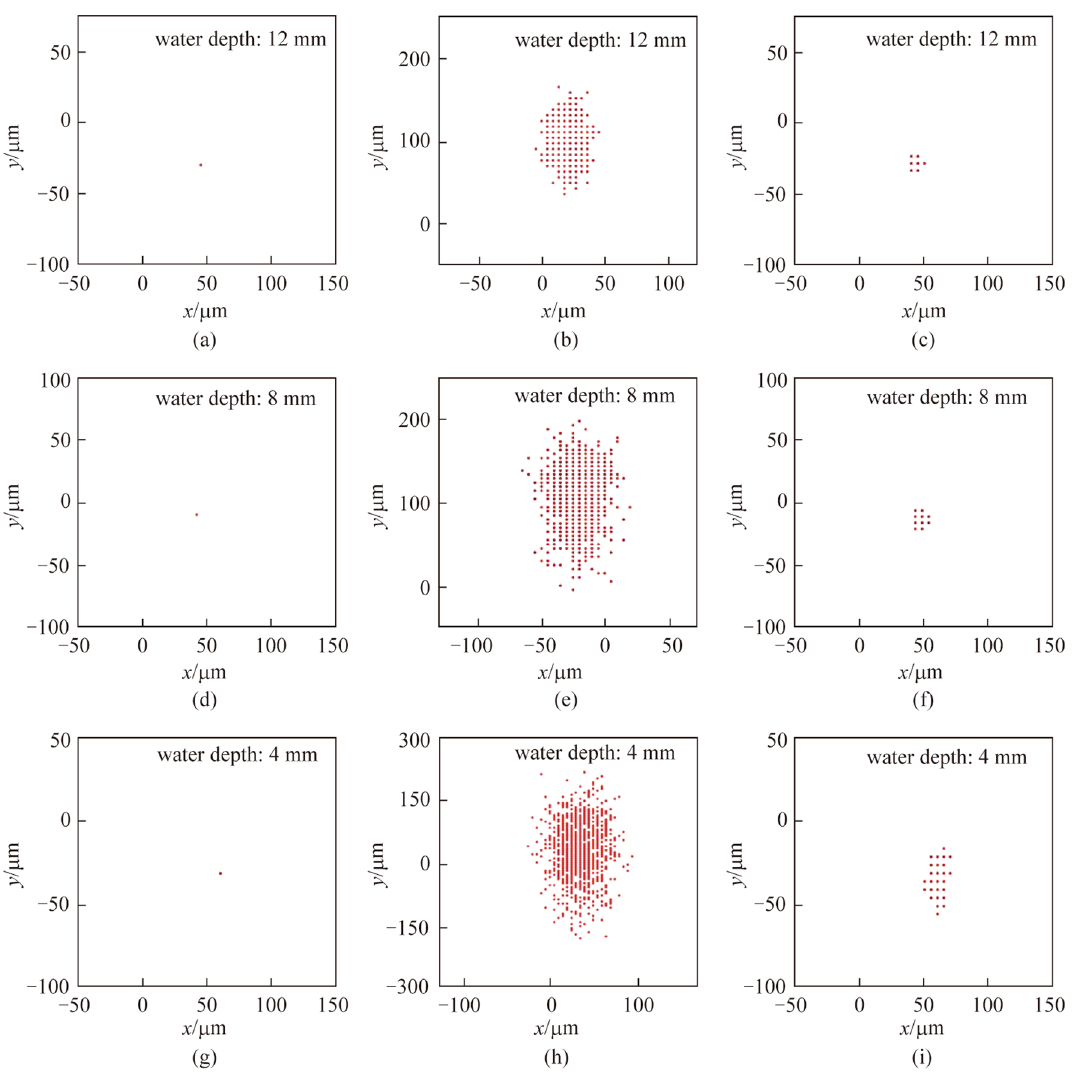
Fig. 6 Centroid distributions of a , d , g undistorted beam, b , e , h distorted beam, and c , f , i compensated beam with the water depth of 12, 8, and 4 mm Table 1 RMS of the beam centroid of the undistorted beam, the dis- torted beam and the compensated beam Water depth/